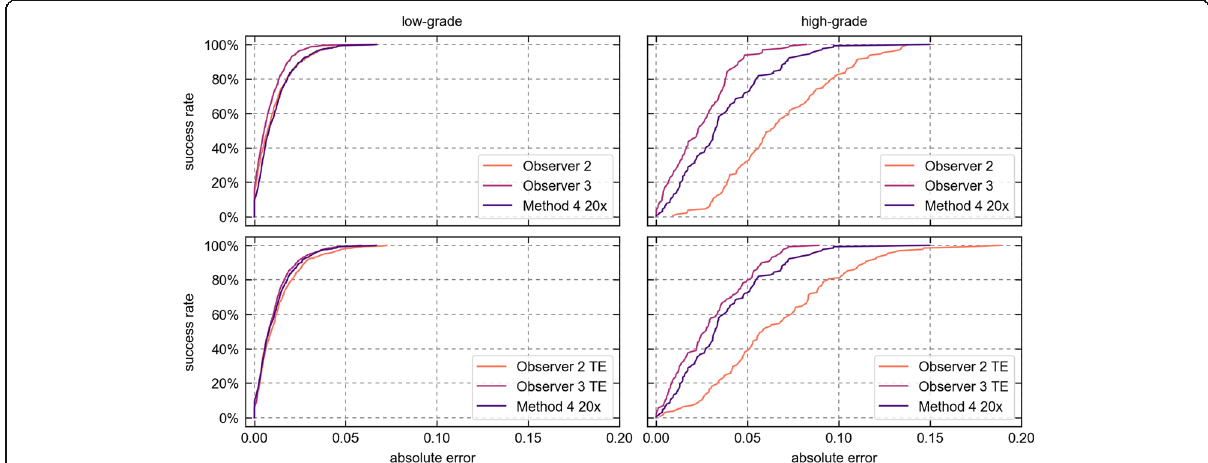
Fig. 6 Success rate curves of Observer 2 & 3 and Method 4. The top row compares the inherent error of Observer 2 & 3 and Method 4. The bottom row compares the estimated total error of Observer 2 & 3, computed as the sum of the inherent error and the estimated sampling error of SPC, with the total error of Method 4, which is unaffected by the sampling error